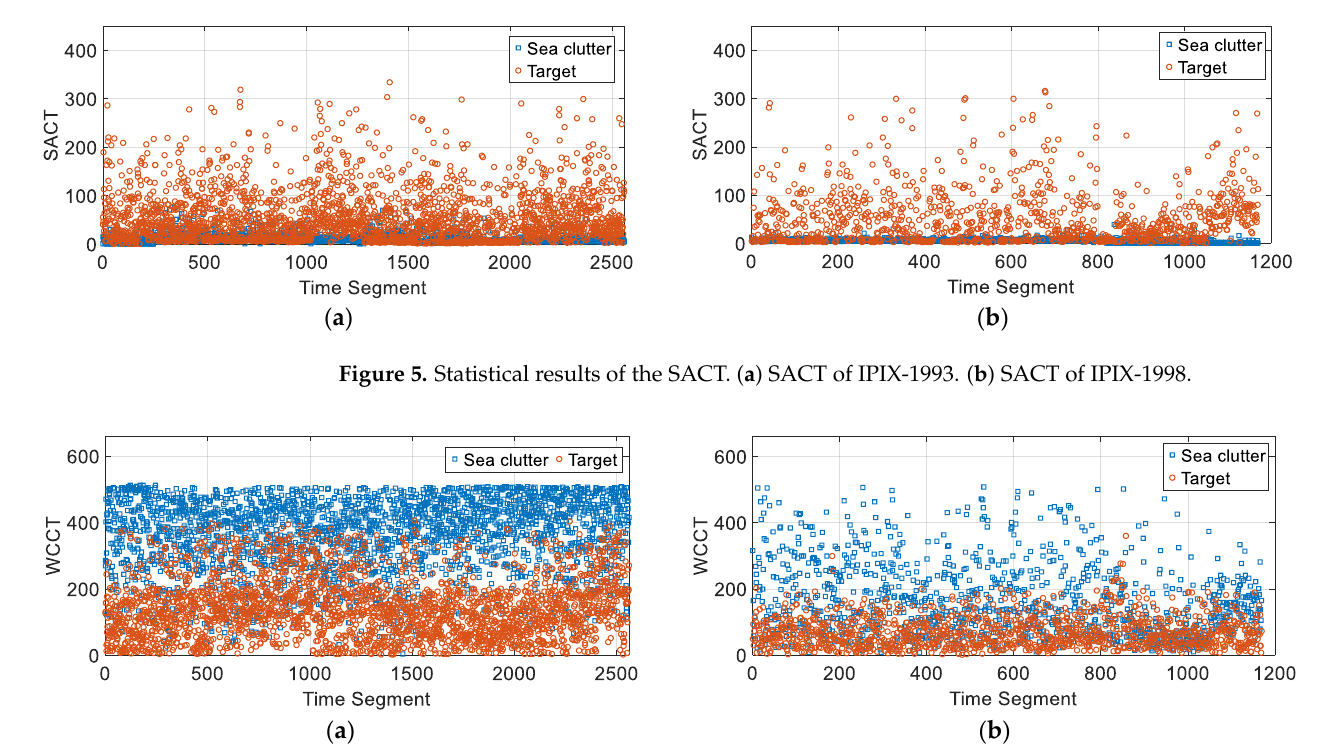
Figure 6. Statistical results of the WCCT. ( a ) WCCT of IPIX-1993. ( b ) WCCT of IPIX-1998.